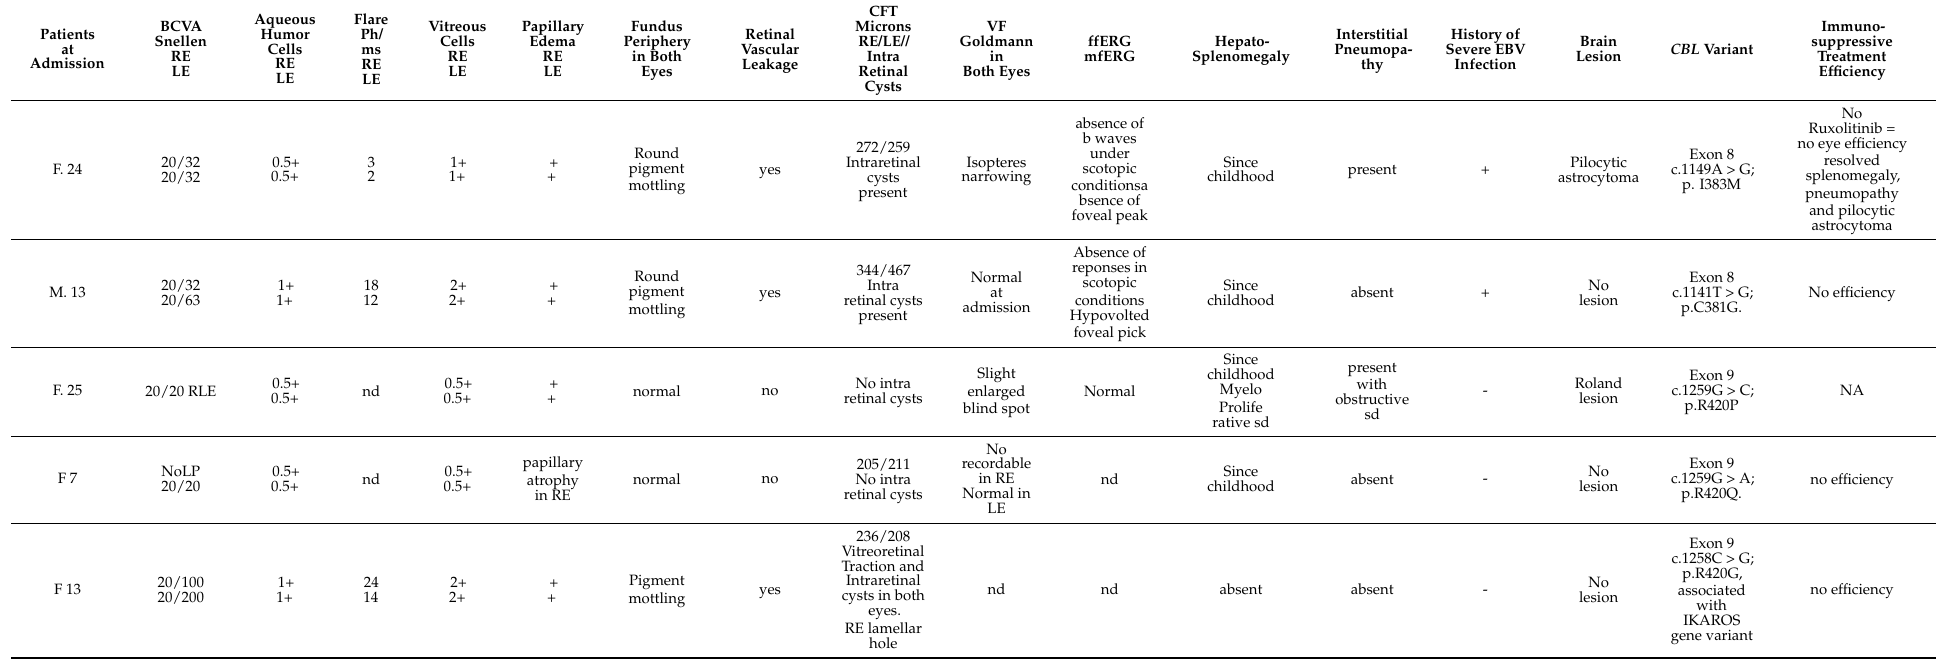
Table 1. Summary of clinical features and management of CBL